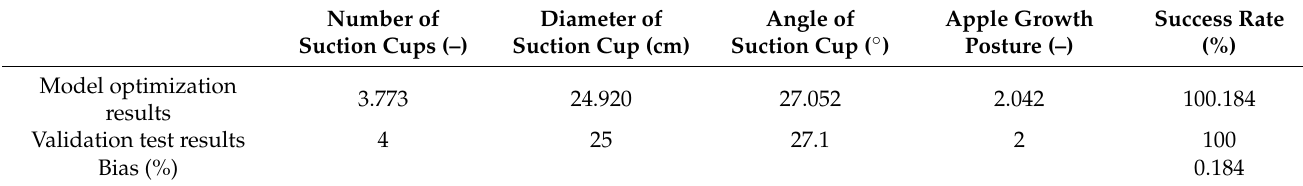
Table 9. Comparison of validation test and model prediction